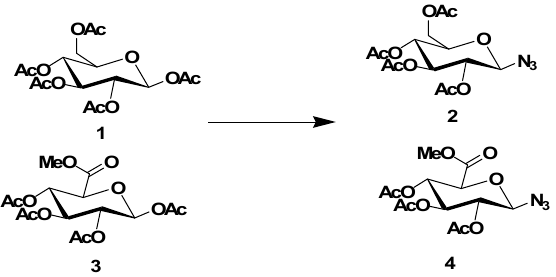
Scheme 1. Synthesis of Azide Intermediates 2 and 4 . Reagents and conditions: azidotrimethylsilane, SnCl 4 , CH 2 Cl 2 , rt, 2 h.